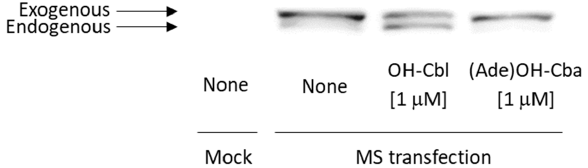
Figure 3. Western blotting of MS protein in MS cDNA-transfected cells grown with or without OH-